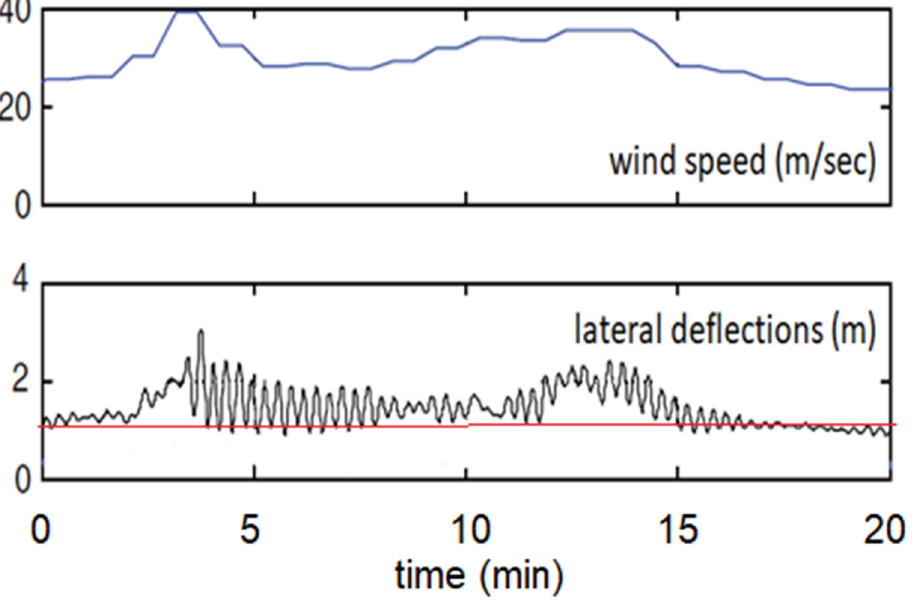
Figure 1. Response of the Humber Bridge, UK, with a 1400 m-long span, to strong wind, derived from GNSS data. ( top ) Long-period component of wind record (no gusts shown) during an extraordinary wind event. ( bottom ) Recorded lateral deflections (deviations from the red line) indicate a combination of semi-static and dynamic oscillations at mid-span, with a total amplitude of about 2 m. Modified after [11]. These GNSS-derived deflections have a small SNR (signal-to-noise ratio) and are a priori reliable. This is not, however, the case with small deflections of short, stiff bridges.